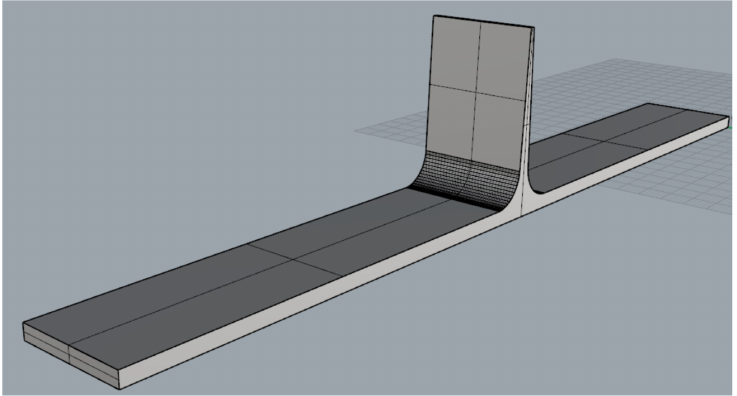
Figure 1. Simplified ribbed plate